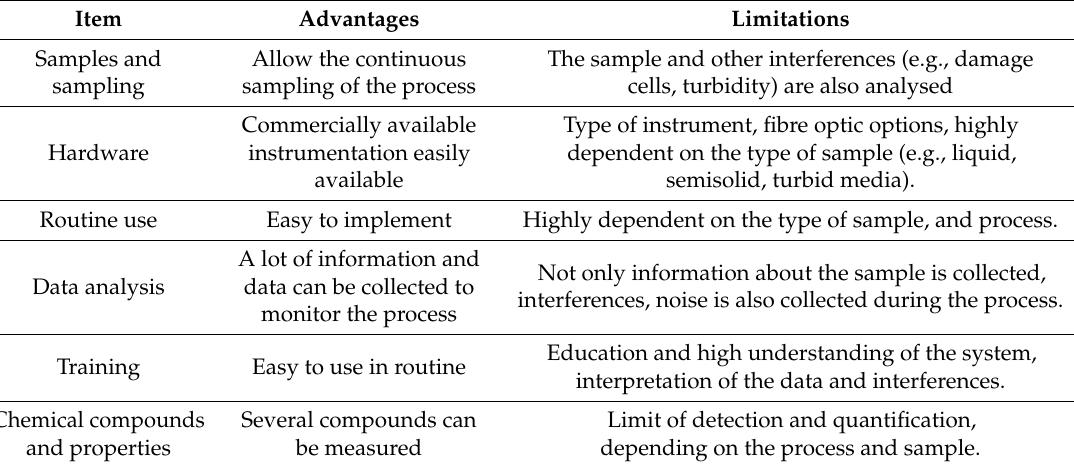
Table 1. Advantages and limitation of the use of UV-Vis spectroscopy for the analysis and monitoring of bioprocess and